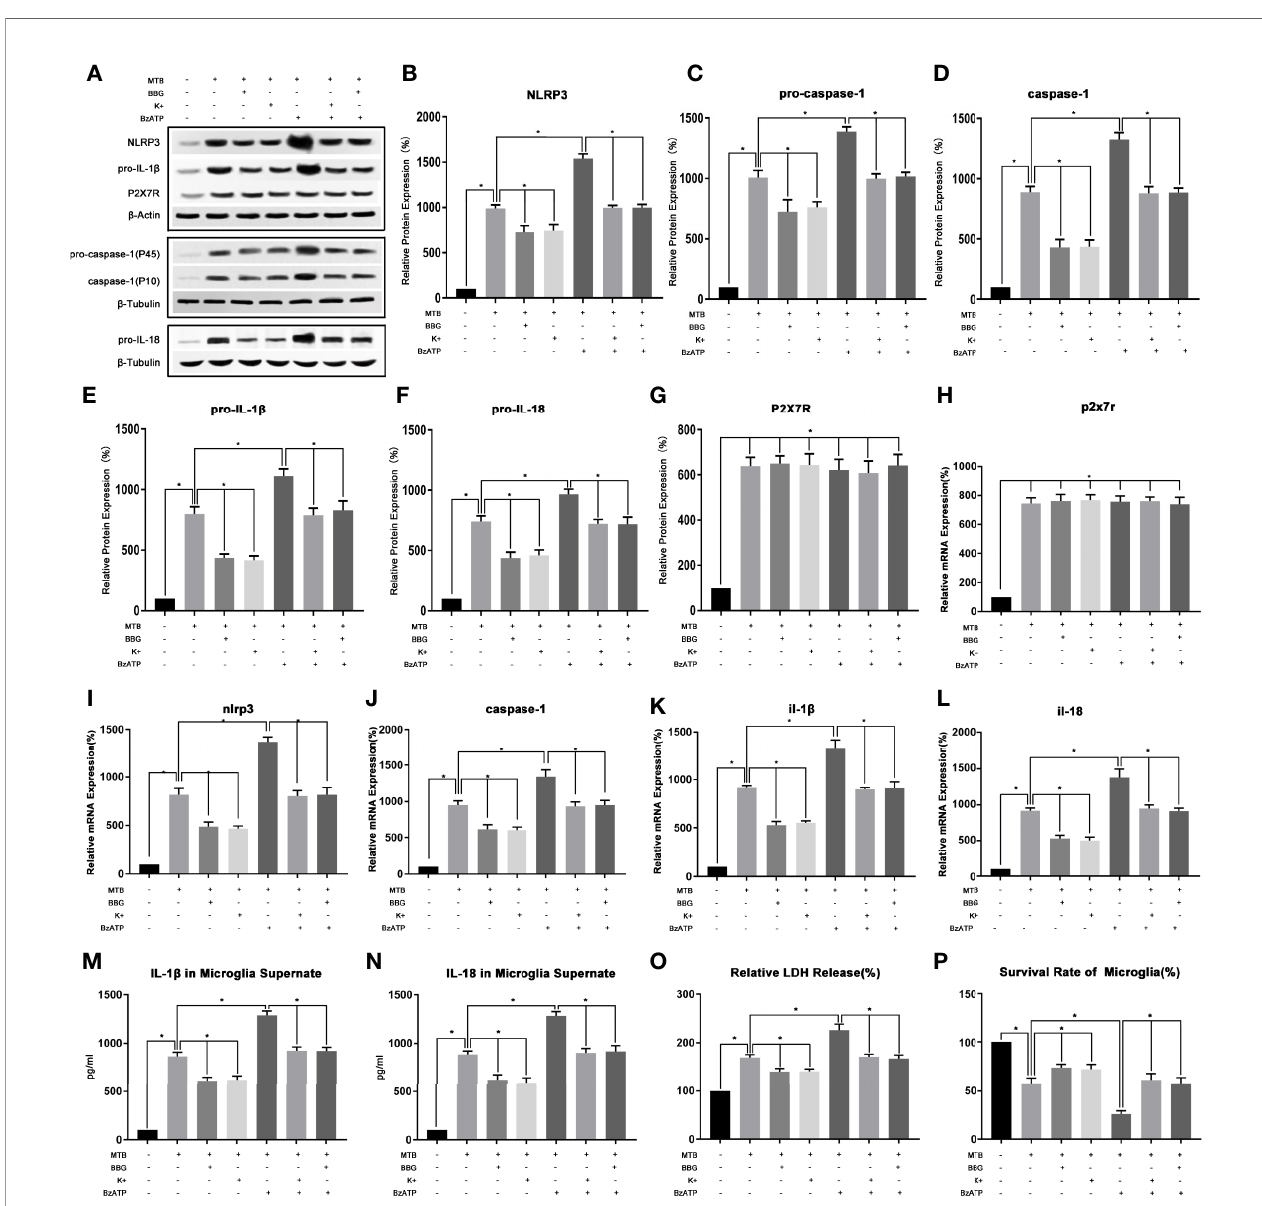
FIGURE 4 | In the process of co-culture, the changes of P2X7R pathway and its intervention factors during the activition of NLRP3 in fl ammasome in microglia. (A – G) Use Western Blot to detect the relative protein expression of NLRP3, pro-caspase-1, caspase-1, pro-IL-1 b and pro-IL-18, and P2X7R in control group, co- culture group, BBG group, K + group, BzATP group, BBG+BzATP group and K + +BzATP group. (H – L) Use Real-time PCR to detect the relative mRNA expression of nlrp3, caspase-1, il-1 b and il-18, and p2x7r in control group, co-culture group, BBG group, K + group, BzATP group, BBG+BzATP group and K + +BzATP group. (M, N) Use ELISA to detect the IL-1 b and IL-18 secretion in supernatant of control group, co-culture group, BBG group, K + group, BzATP group, BBG+BzATP group and K + +BzATP group. (O) Use LDH release to measure the cytotoxicity in control group, co-culture group, BBG group, K + group, BzATP group, BBG+BzATP group and K + +BzATP group. (P) Use MTT analysis to detect the cell survival rate in control group, co-culture group, BBG group, K + group, BzATP group, BBG +BzATP group and K + +BzATP group. *P <